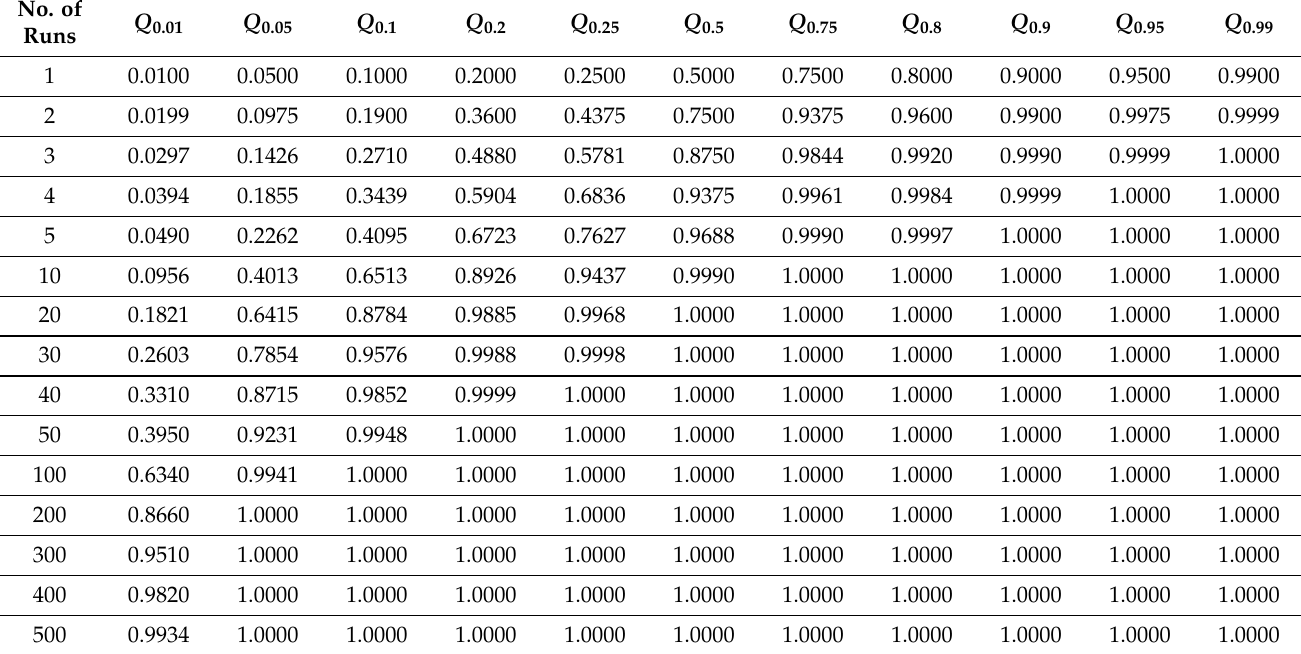
Table 1. Probabilities for multiple runs rounded to four